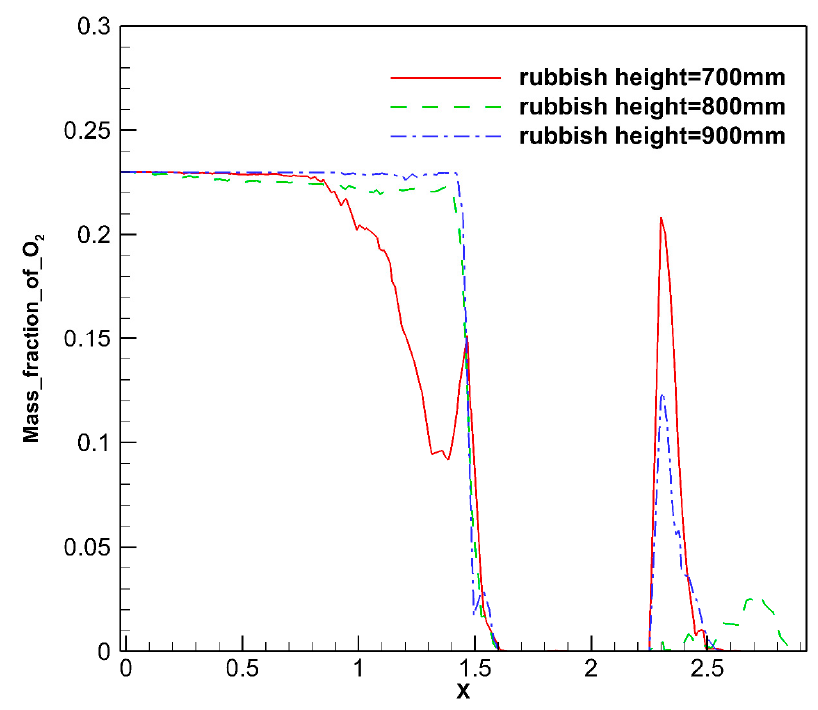
Figure 21. Mass fraction of oxygen on the line at Y = 1.09 m with the primary burner position = 1500 mm and the cooling air with the mass flow rate = 0.07 kg/s.